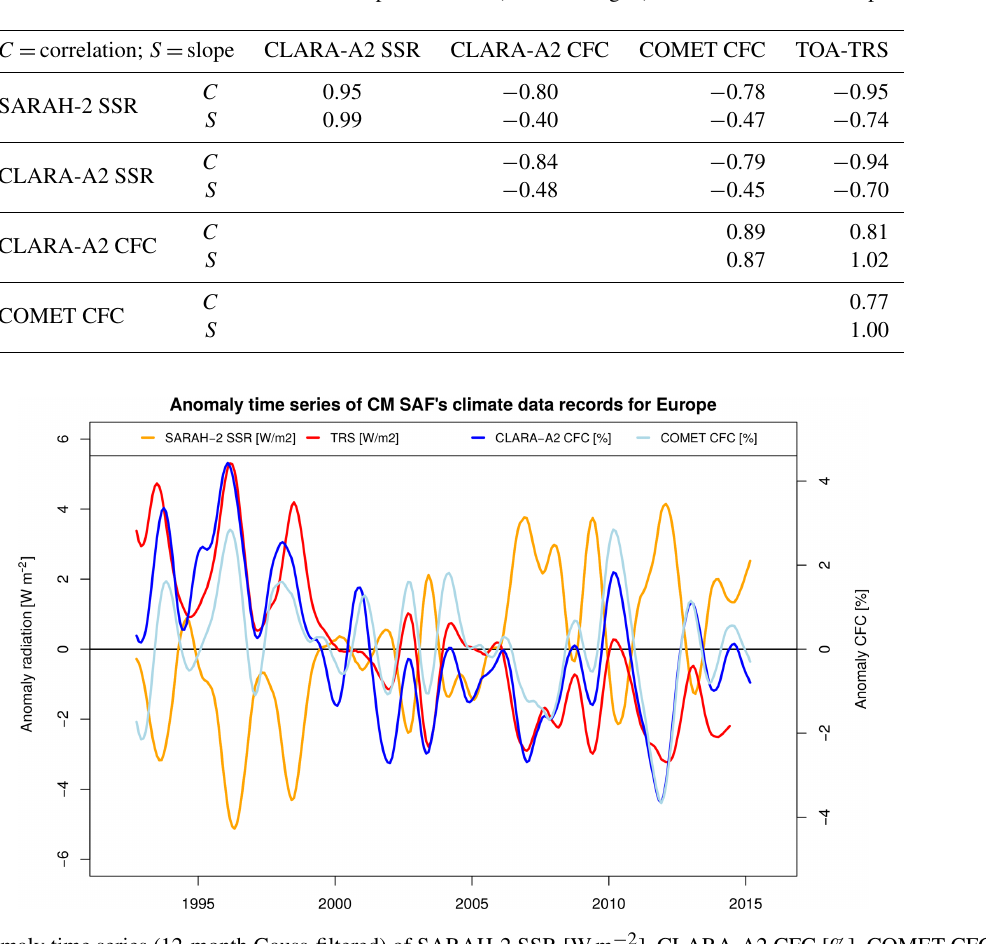
Figure 1. Mean anomaly time series (12-month Gauss-filtered) of SARAH-2 SSR [Wm − 2 ], CLARA-A2 CFC [%], COMET CFC [%] and TRS [Wm − 2 ] for the time period 1992–2015. There are two y -axis: Radiation [Wm − 2 ] (left) and CFC [%] (right). Note: CLARA-A2 SSR anomalies are not included due to its incomplete spatial coverage (see Sect.